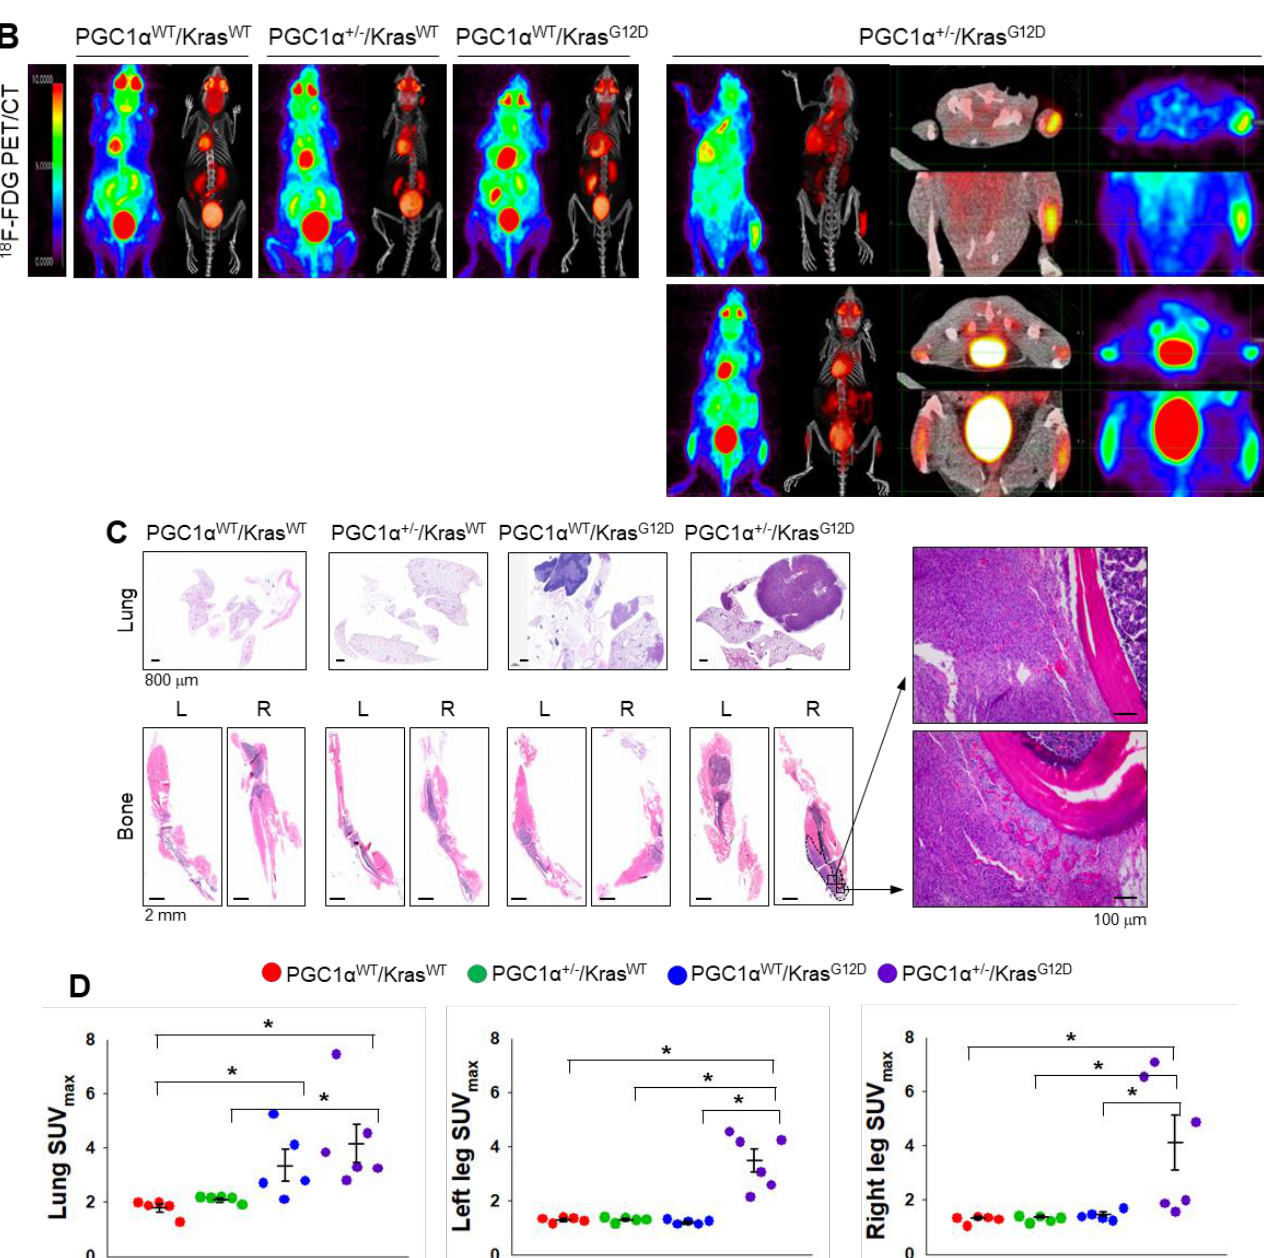
Figure 3. Bone metastasis of Kras G12D -driven lung cancer is promoted by a single Pgc1 α allele knockout. ( A ) Genotyping PCR analysis of PGC1 α WT ; Kras WT , PGC1 α +/ − ; Kras WT , PGC1 α WT ; Kras G12D , and PGC1 α +/ − ; Kras G12D mice are shown. The mice were selected from crossing heterozygous Tg Kras G12D and heterozygous PGC1 α +/ − mice based on the genotyping of the progeny. In accordance with a Mendelian trait, approximately 25% of the offspring exhibited in each group. ( B ) PET images of mice between 16 and 17 weeks of age. All images were normalized to the same maximal standard uptake value (SUVmax) to facilitate the comparison of PET lesions. Three-dimensional renderings of fused PET/CT images of the 5 mice from ( A ). ( C ) Hematoxylin and eosin (H&E)-stained tissue sections of lung (top) and leg (bottom) at the whole scan level and at a magnified level (right). In the H&E-stained tissue, tumors are circled in black. High Resolution Images are showed in Figure S8. ( D ) Quantification of tumor uptake value (SUVmax) and mean standardized uptake vales (SUVmax) of lung and legs. The whole western blot images are -shown in Figure S7. * p < 0.05 by Student’s t -test.